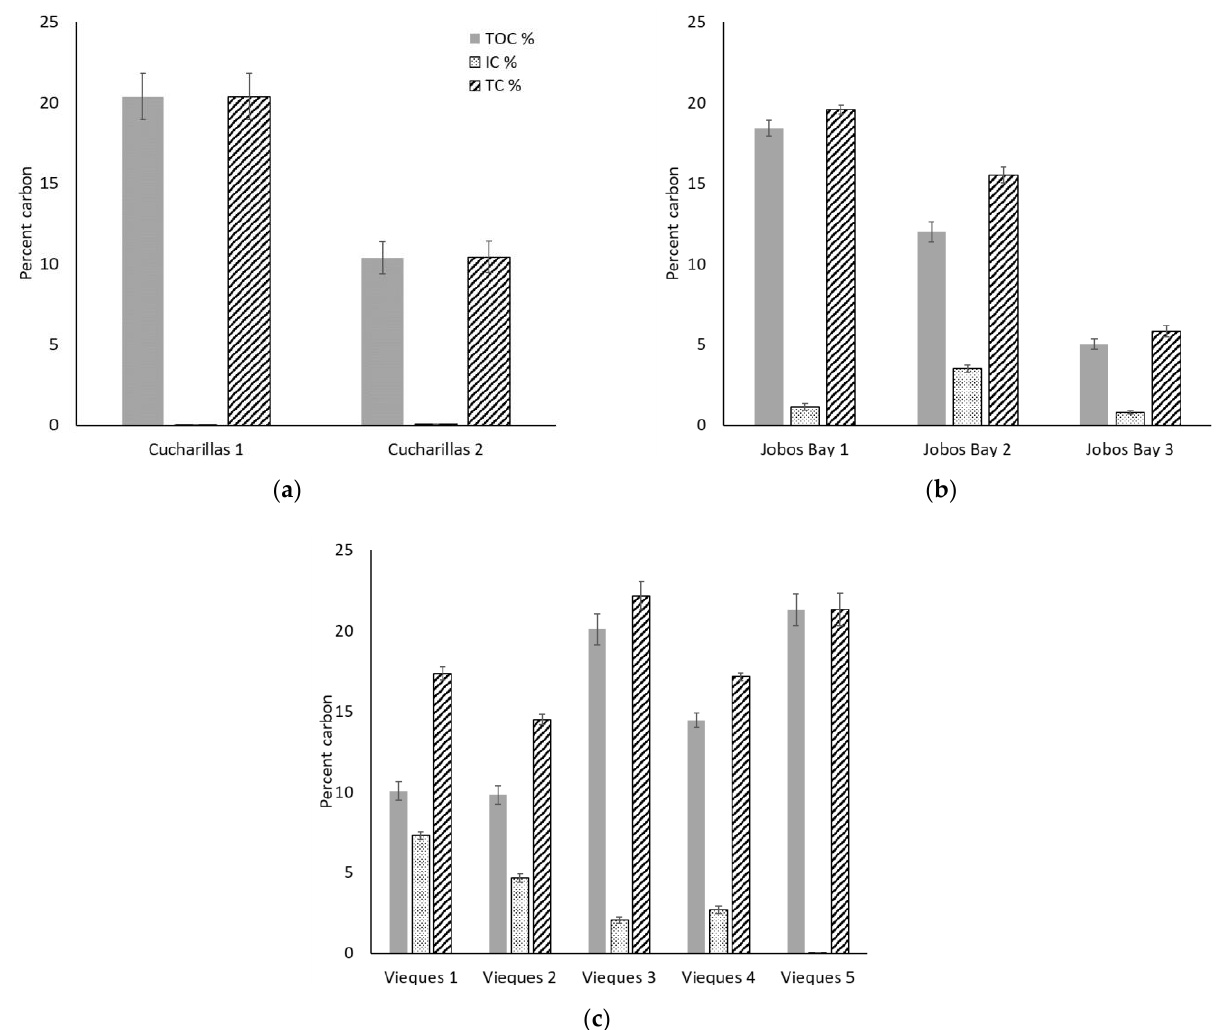
Figure 4. Average percent total organic carbon (TOC, shaded), inorganic carbon (IC, dotted), and total carbon (TC, striped) in the top 30 cm of soil at each site of each location – ( a ) Cucharillas, ( b ) Jobos Bay, and ( c ) Vieques. Error bars represent ± standard error.